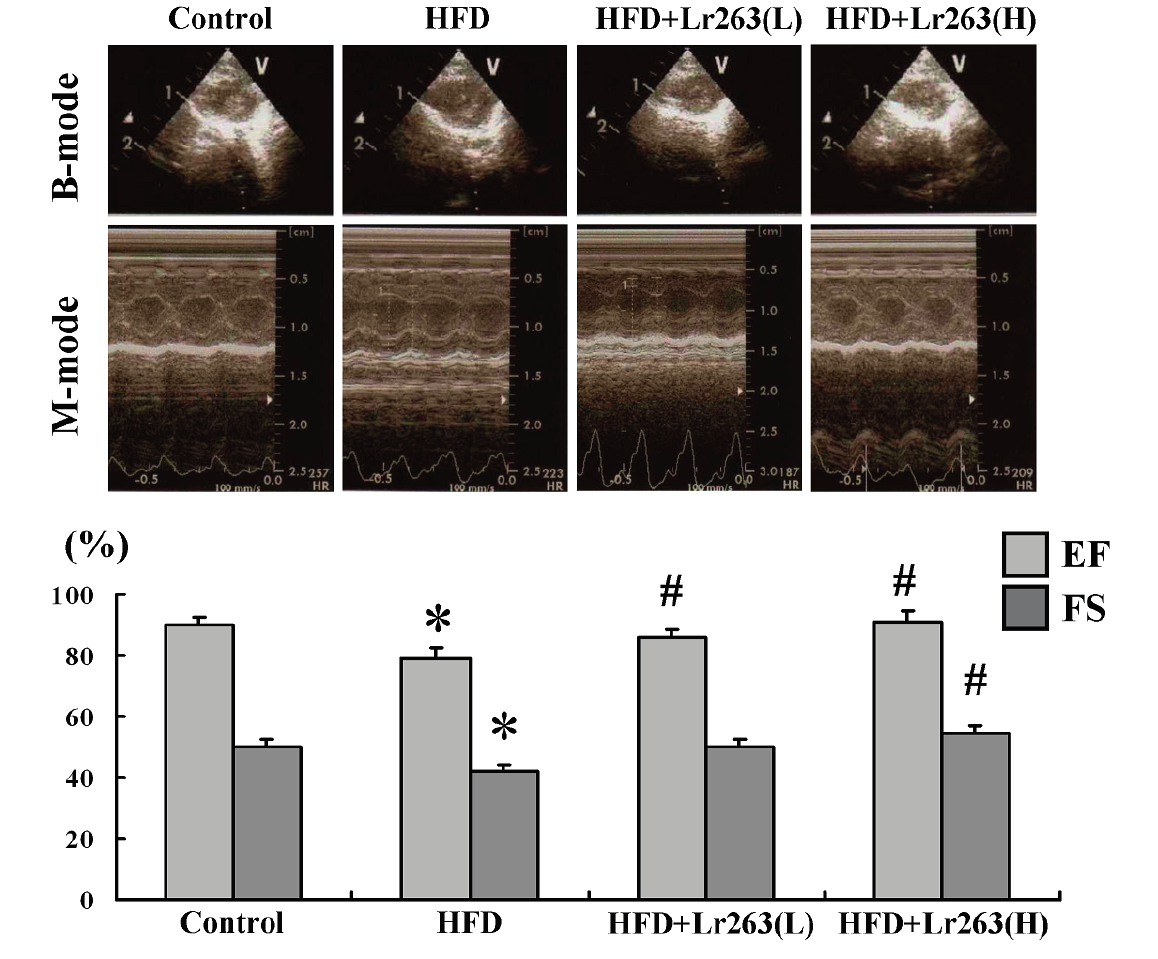
Figure 4. The echocardiography analysis of the hamster was performed using a 10 MHz transducer (GE 10S-RS). The B-mode was visualized for two-dimensional (long-axis and short-axis of the left ventricle) mode images and B-mode perspectives were further used to evaluate the left ventricle for the M-mode cursor. An M-mode evaluation of heart function was performed by comparing the left ventricular systolic and diastolic distances, which are shown as ejection fraction (EF) values and fractional shortening (FS) values ( n = 6 in each group, * p < 0.05 compared with control group, and # p < 0.05 compared with HFD group). The sections with MT staining show fibrosis in portions of the HFD-only treatment hamster hearts (Figure 5). After heat-killed Lr263 (625 mg/kg-hamster/day) treatment, the fibrotic portions of the HFD treatment hamster hearts improved. Moreover, after heat-killed Lr263 (3125 mg/kg-hamster/day) treatment, the fibrotic portions in the HFD-only treatment hamster hearts exhibited more